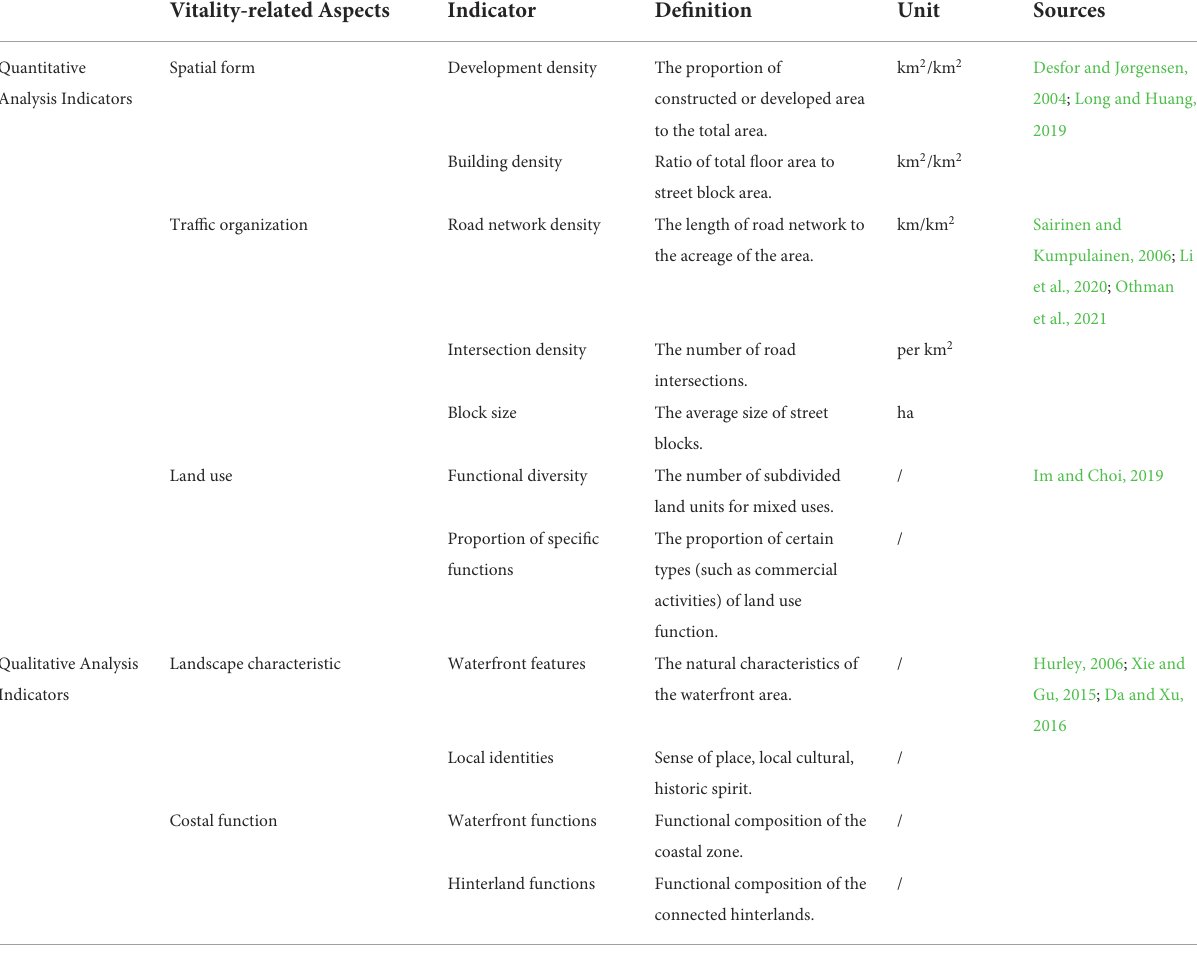
TABLE 1 Environmental indicators related to urban coastal zone